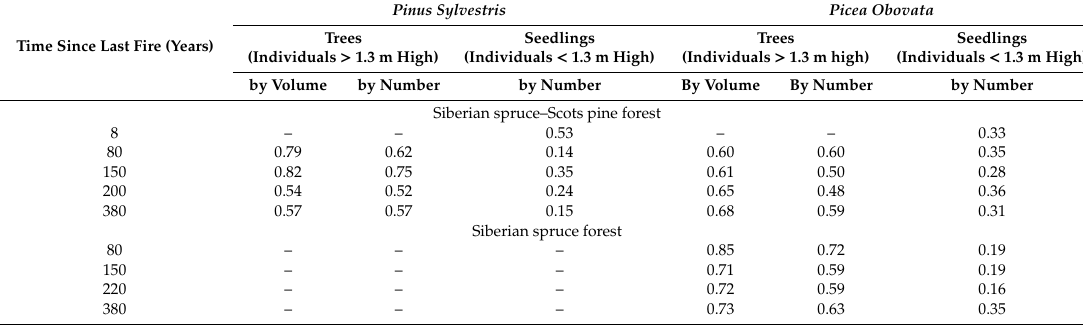
Table 4. The vitality state index of trees and seedlings of Pinus sylvestris and Picea obovata in forests with di ff erent post-fire